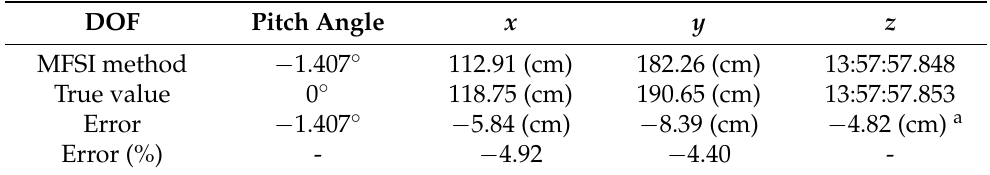
Figure 12. The dual receivers are applied in field tests: ( a ) the dual receivers tracking system, ( b ) a PIG with an extremely low-frequency (ELF) transmitter in the pipeline. Table 6. The tracking errors of the dual receivers tracking system and MFSI algorithm in the field